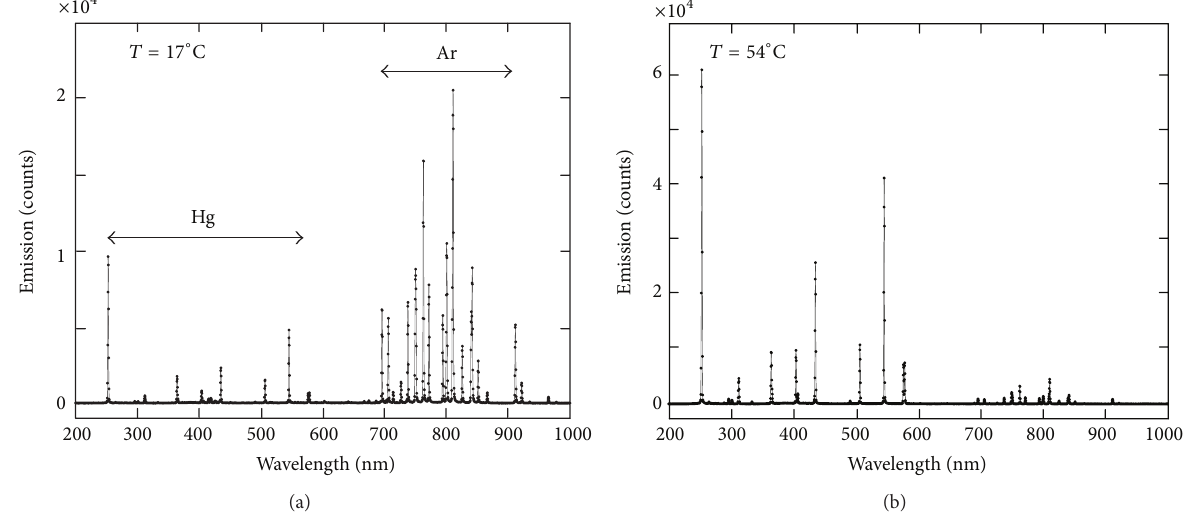
Figure 6: The emission spectrum of the integrated MW/UV lamp in the 200 ÷ 1000nm region: (a) MW power = 40W, 𝑇 = 17 ∘ C; (b) MW power = 40W, 𝑇 = 54 ∘